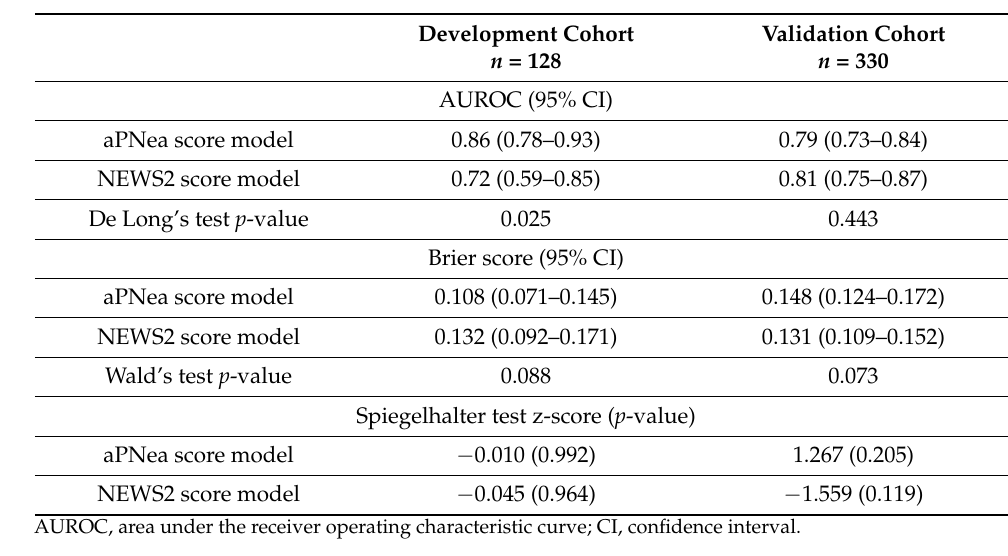
Table 4. aPNea score and NEWS2 score discrimination and calibration performances in the develop- ment and validation cohorts.